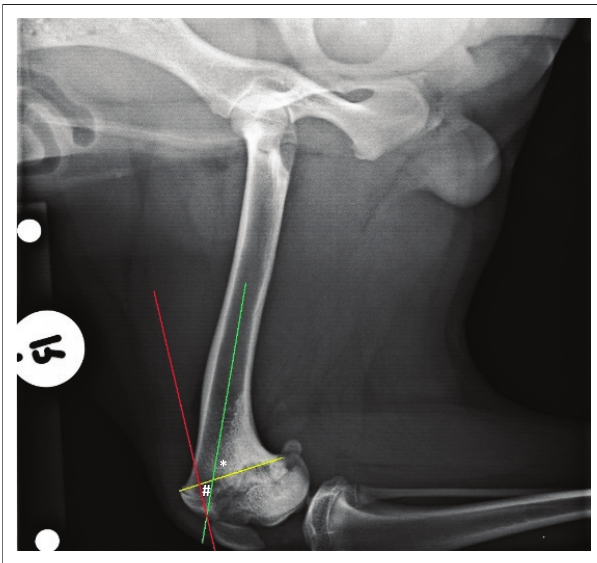
FIGURE 3: Radiographic image: Preoperative mediolateral view of the right femur. The centre of rotation of angulation (#) measured 23° and was located at the most cranial extent of the right distal femoral epiphysis.